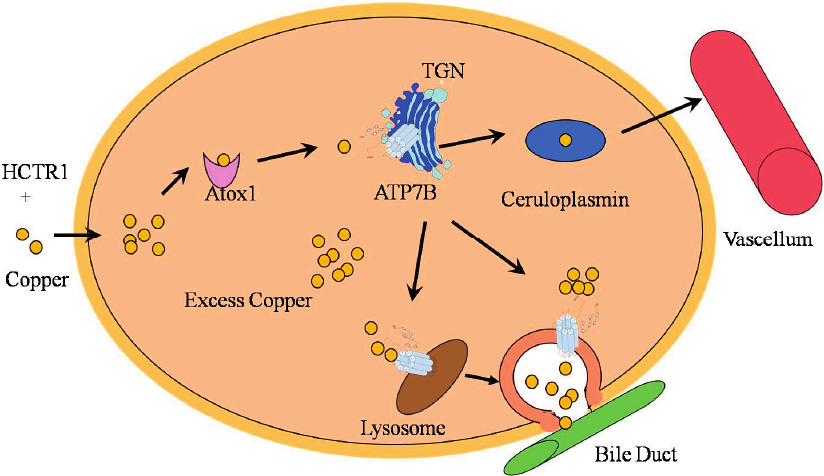
Figure 2. Copper is delivered by HCTR1 to cytosol where it mainly binds to